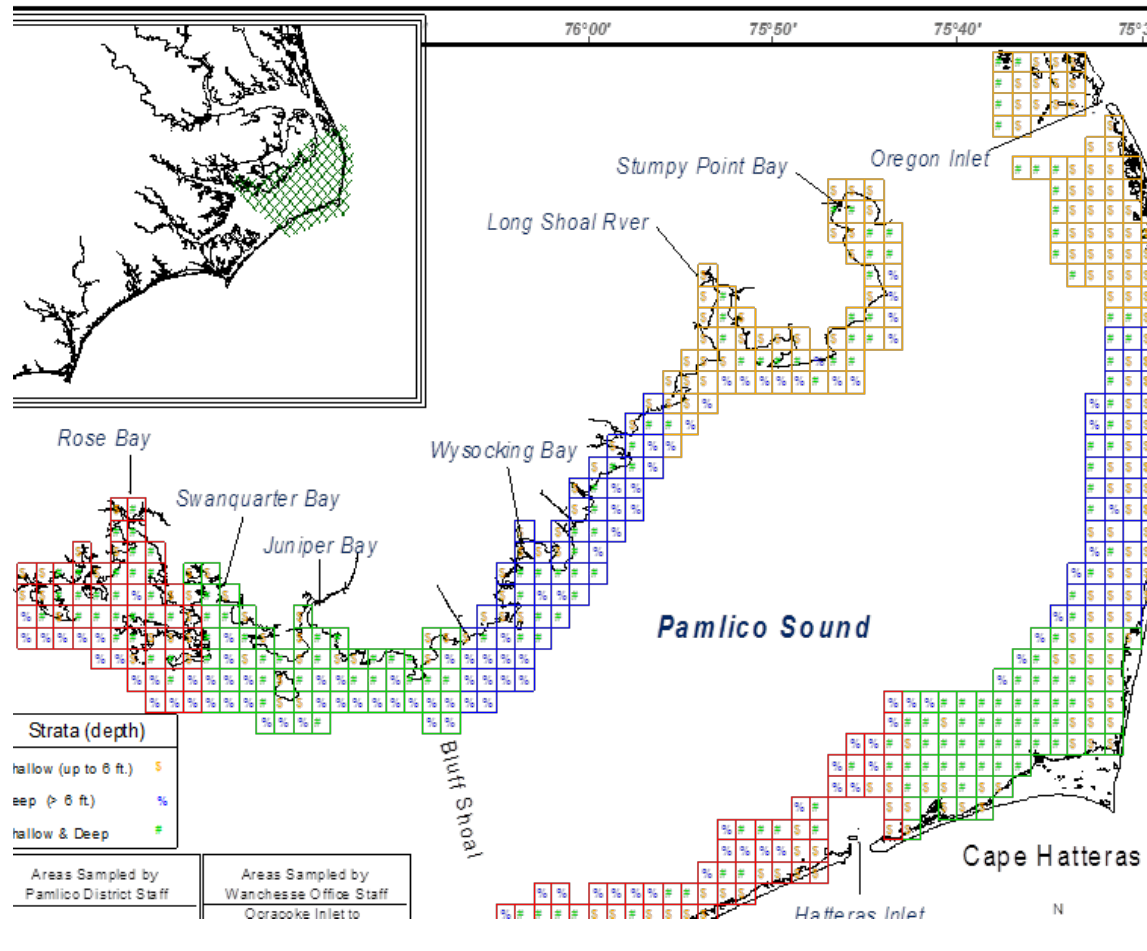
Figure 63. Map of the sampling sites for North Carolina’s Estuarine Gillnet fishery independent survey. This survey also operates in several rivers, but only the Pamlico Sound sites were used for developing an index of horseshoe crab abundance for this region (map provided by NC